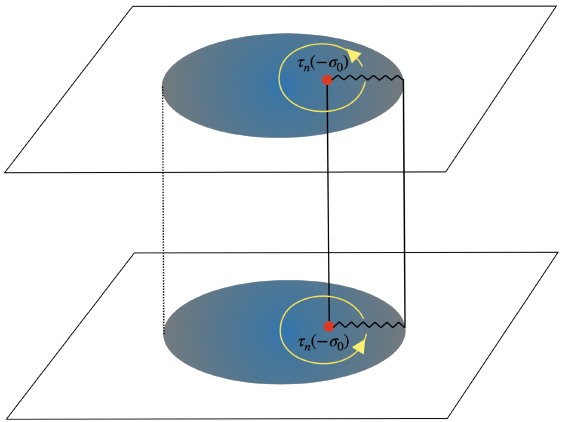
Figure 2 . An illustration of replica wormholes: the dark blue disk is the 2 d Euclidean space H 2 = EAdS 2 . The space is n -tiply replicated and only two of them are shown. The red blob is the twist operator τ n of the Liouville CFT that creates an n -th root branch cut (black wavy line) corresponding to a single “cosmic brane” that creates deficit angle 2 π/n and will be located at the quantum extremal surface (QES), y = ¯ y = − σ 0